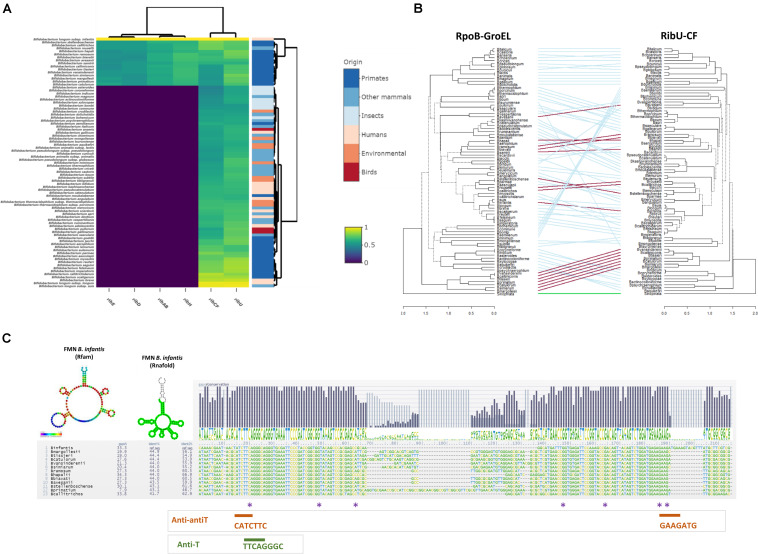
Comparative analysis of riboflavin biosynthesis in Bifidobacterium. (A) Comparative heatmap representing the distribution of riboflavin-associated genes from Bifidobacterium infantis ATCC 15697 across the Bifidobacterium genus. Color gradients indicate the percentage of identity in BLASTP alignments of open reading frames (ORFs) derived from bifidobacterial genomes grouped by origin of isolation; (B) Entanglement trees obtained from the concatenation of rpoB, groEL vs. ribU, ribCF genes across the genus Bifidobacterium. The two Neighbor Joining (NJ) trees were built using the MEGA package (statistical validation of 100 bootstrap replicates) and visualized using the “Dendextend” package in R v3.6.2. Connecting lines are color coded based on the presence (red) or absence (blue) of a rib cluster. The outgroup is indicated in green. (C) Sequence alignment of FMN region in B. infantis and 13 bifidobacterial strains containing a complete rib cluster. Sequence conservation is indicated with a logo for the consensus. Colored asterisks indicate mutations in FMN riboswitch region upstream of the rib cluster identified in ROS-resistant isolates. Prediction of the FMN folding was based on Rfam aligment (bases color-coded based on sequence conservation to the Rfam model RF00050) and was predicted by Rnafold. The obtained structures were obtained using the Infernal and Rnafold predictions in https://structrnafinder.integrativebioinformatics.me/ (Arias-Carrasco et al., 2018).